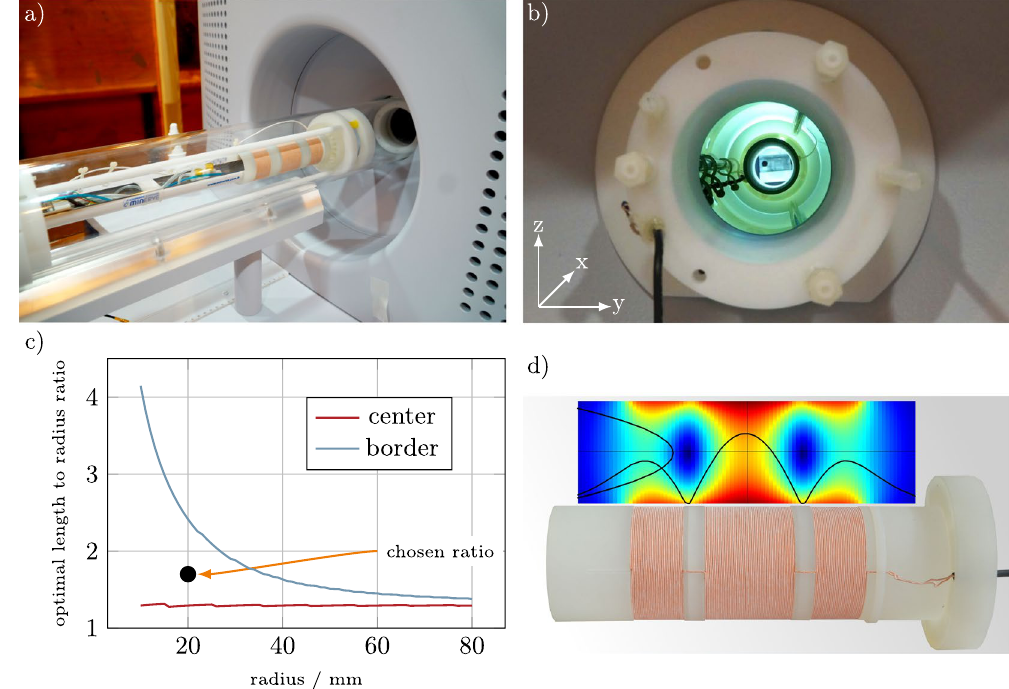
Figure 1. ( a ) Mouse insert placed in front of the scanner bore. The receive coil is mounted within the insert, such that the mouse bed fits inside. ( b ) Gradiometer coil mounted inside the scanner. ( c ) Optimal coil length l per radius R at different radii for the FOV center and FOV border. For the aimed bore diameter of 40 mm a compromise of 50 turns or 34 mm ( l / R = 1.7) was chosen (black dot). ( d ) Gradiometric receive coil with a simulated field profile using numerical evaluation of the Biot-Savart